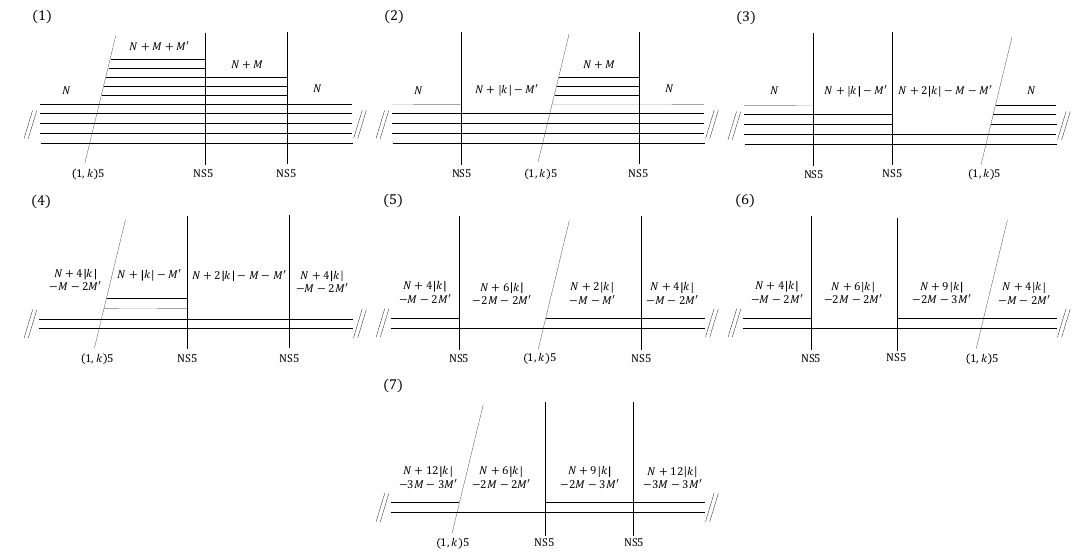
Figure 8 . Illustration of the duality cascade for the U( N ) k × U( N + M + M 0 ) − k × U( N + M ) 0 gauge theory with 2 | k | < M ≤ 3 | k | and | k | < M 0 ≤ 2 | k | ( N = 5 , M = 3 , M 0 = 2 , k = 1 in